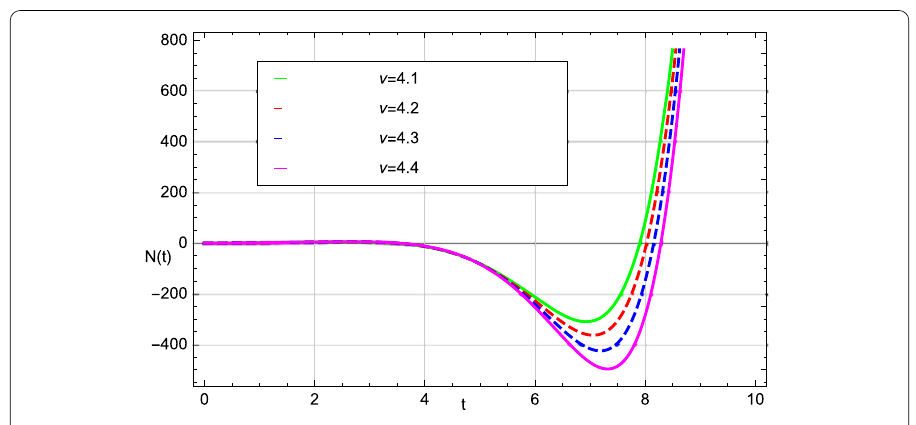
Figure 5 Solution (13) for N ( t ) and